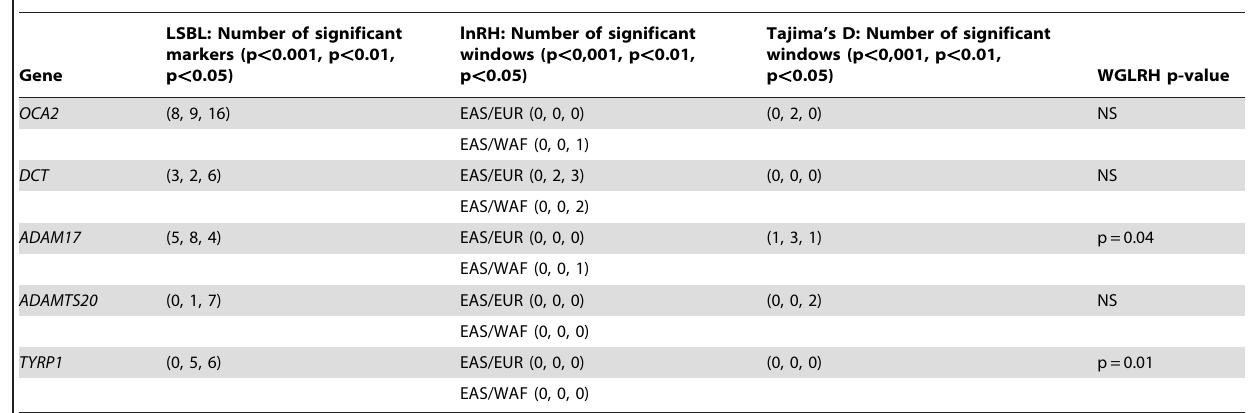
Table 1. Tests of positive selection for the five pigmentation genes analyzed in this study in the East Asian HapMap sample.